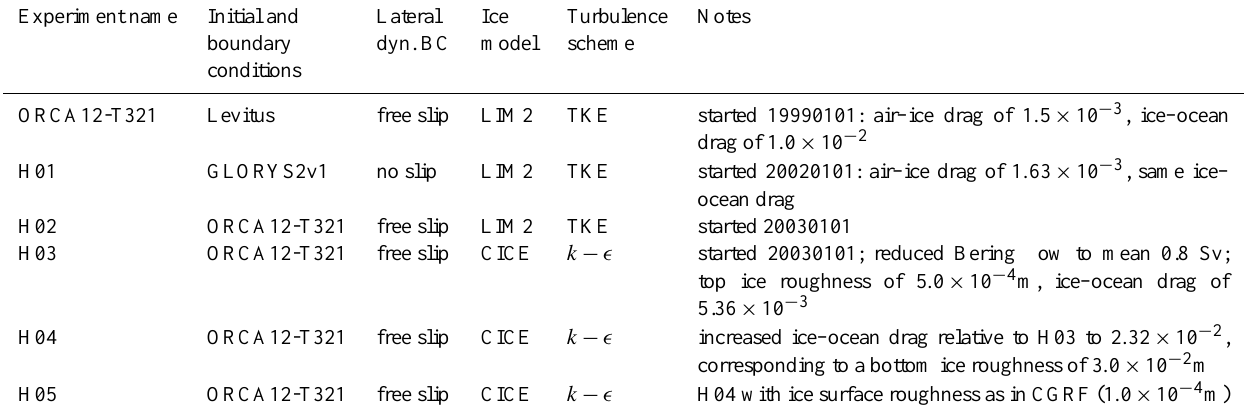
Table 1. Summary description of the different hindcasts produced to date. Dates are given in YYYYMMDD format. Experiment